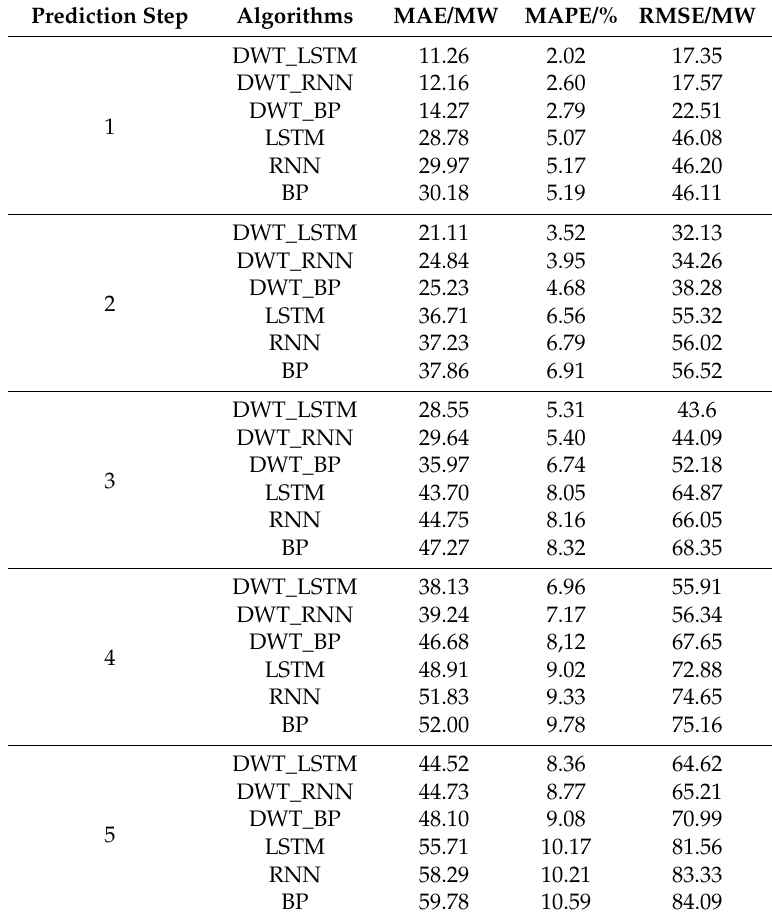
Table 2. Evaluation indexes of farm 2.